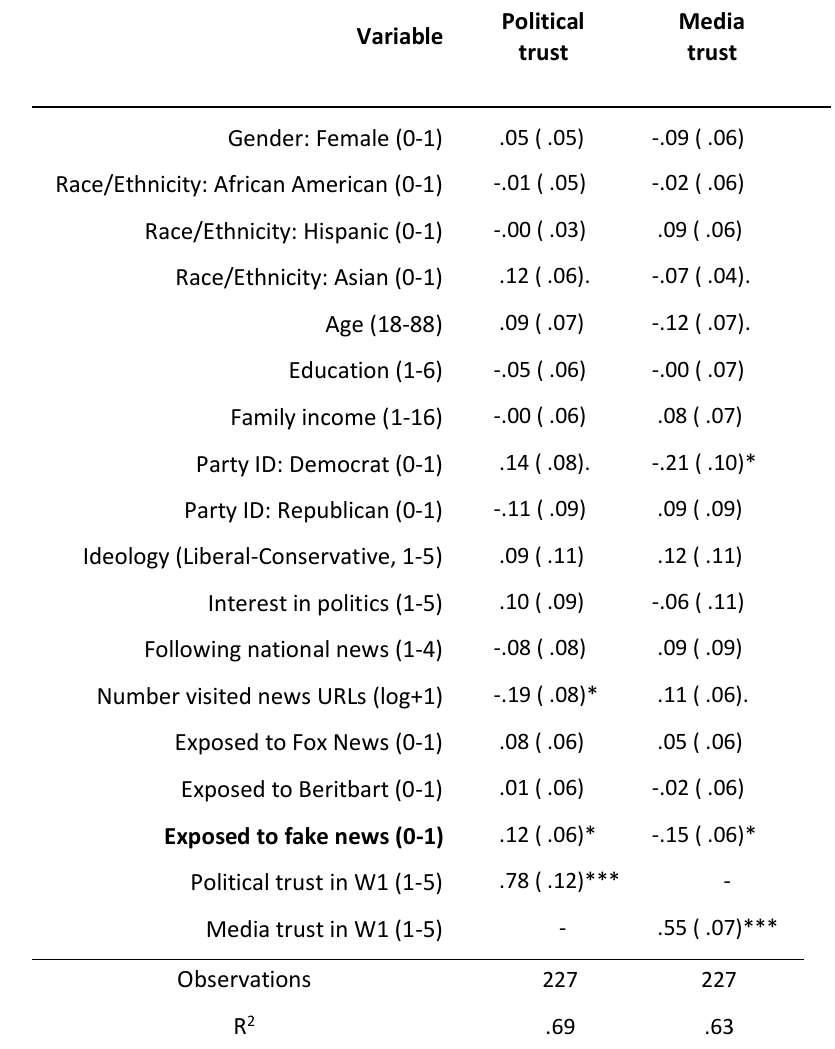
Table B4. Predictors political and media trust. The table includes standardized coefficients from ordinary least squares regressions with multiple imputation